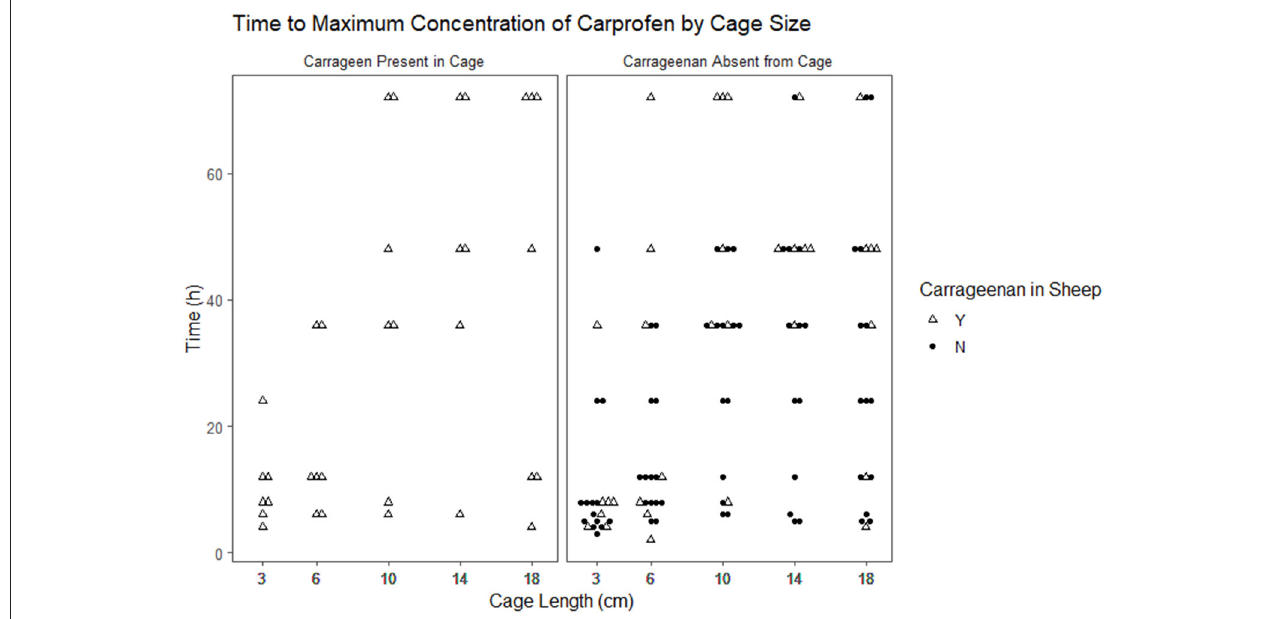
FIGURE 3 | Scatterplot of the time to maximum concentration of carprofen by cage size and carrageenan presence within the cage. the raw data plots and this was also seen in our data, although it was not included in the PK